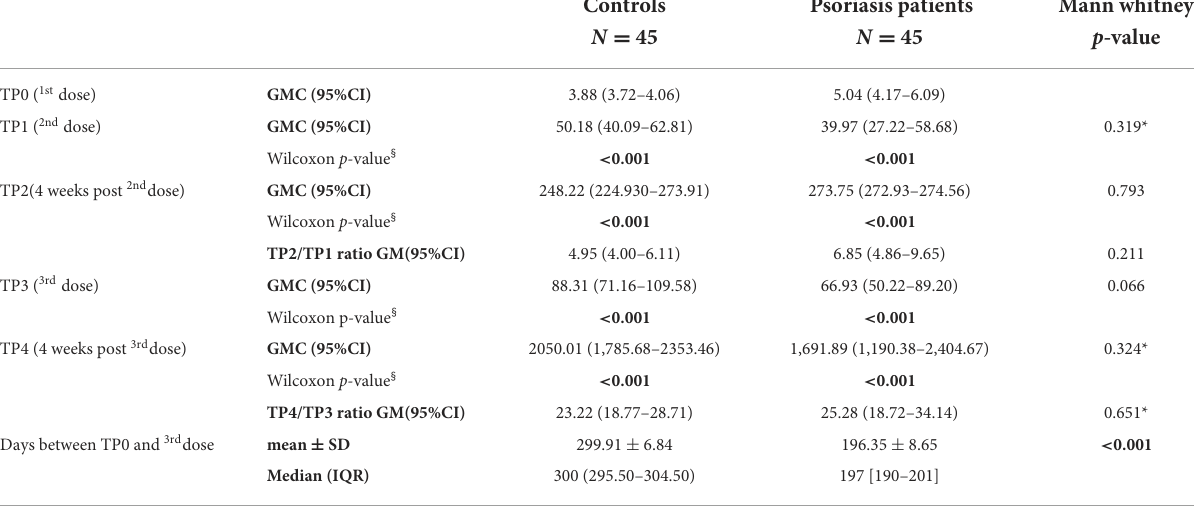
TABLE 2 Geometric mean of concentration (GMC) and GM ratios of anti SARS-CoV-2 spike protein IgG at different time points, in psoriasis patients and control group.